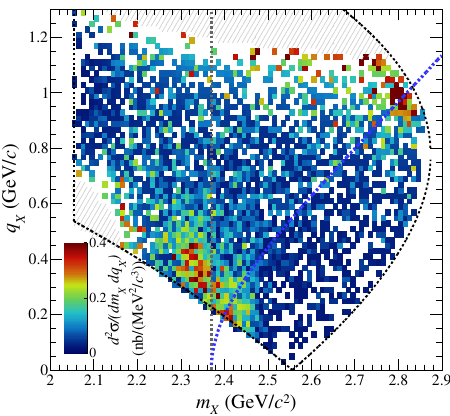
Figure 1. Two-dimensional distribution of the invariant mass of Λ p pair ( m X ) and the momentum transfer to the pair ( q X ). The black dotted lines show the kinematical limit in the reaction. The gray dotted line is the mass threshold of m ¯ K + 2 m N . The blue dotted curve shows the kinematical line of the quasi-free reaction. (See the text for more details.) The figure was taken from Ref. [10].